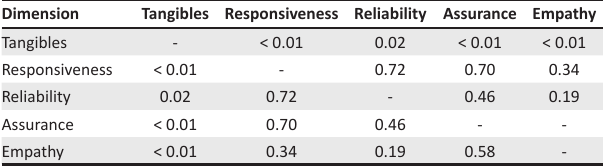
TABLE 1: Post hoc results of analysis of variance between dimensions.